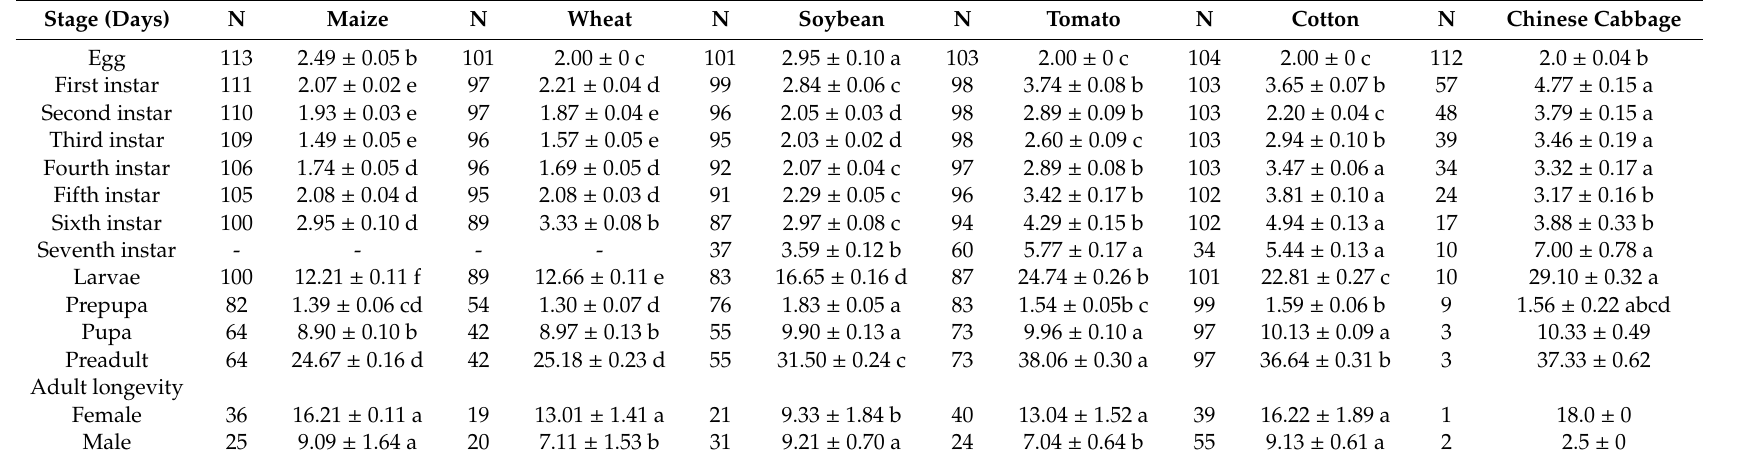
Table 1. Developmental time and longevity (M ± SE) of di ff erent life stages of S. frugiperda fed on six plant species.